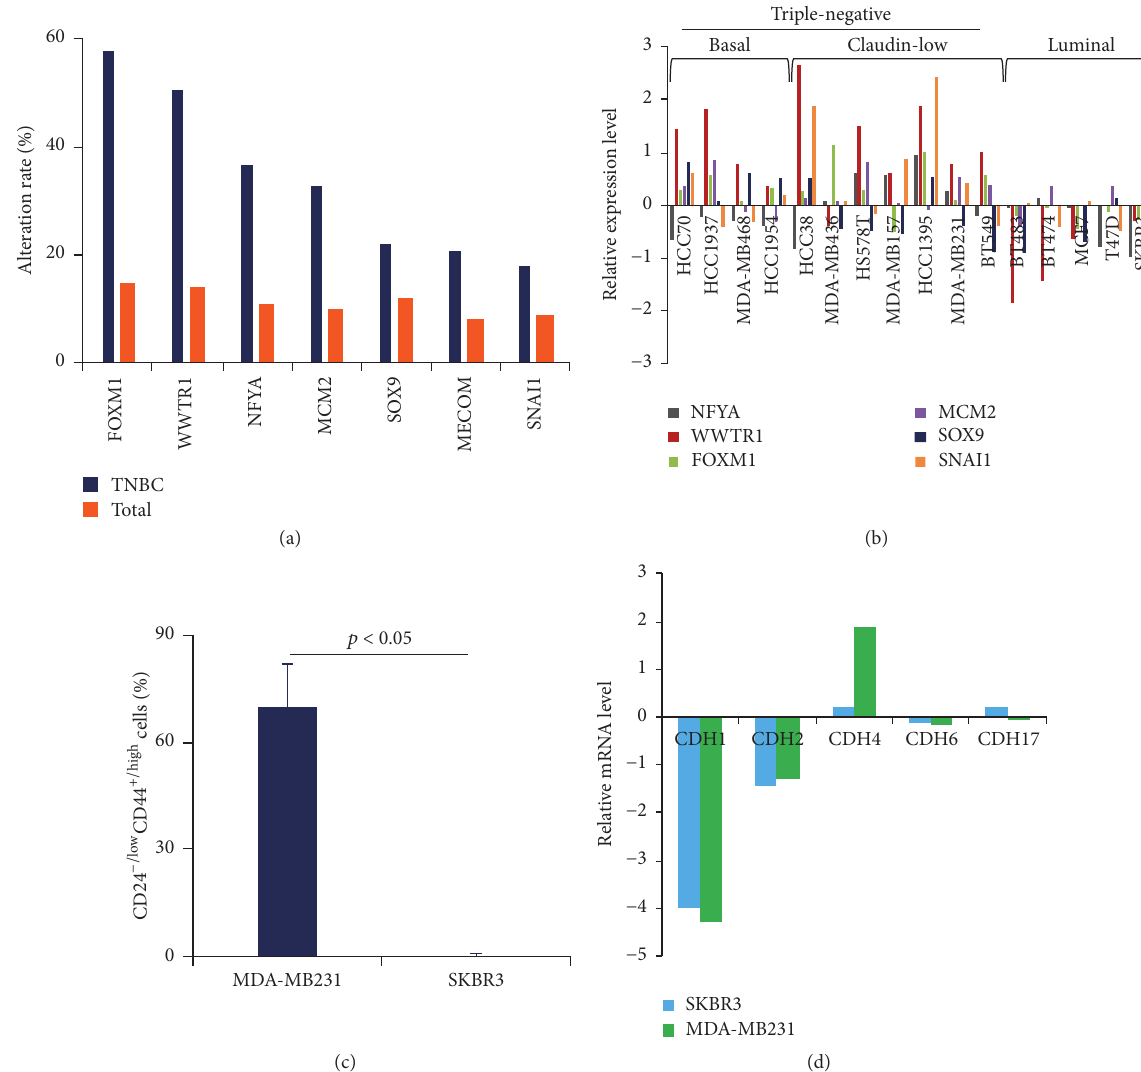
Figure 3: Stem cell-related transcription factors and cancer stem cells are enriched in TNBC cells. (a) The alteration rates of stem cell-related transcription factors (SC-TFs) in TCGA breast cancer samples ( 𝑛 = 960 ) or TCGA TNBC samples ( 𝑛 = 116 ). (b) The expression levels of SC-TFs were elevated in TNBC cells including basal-like and claudin-low. The expression data of the indicated SC-TFs were retrieved from breast cancer cell lines dataset (ArrayExpress accession number E-MTAB-181) by suing UCSC Cancer Genomic Browser according to the instructions. (c) The population of CSCs was higher in basal-like cells MDA-MB231 but lower in luminal subtype of cells SKBR3. The population of CSCs was determined by the staining of stem cell marker CD 24 −/ low CD 44 +/ high followed by flow cytometry. (d) The expression levels of CDH1, 2, 4, 6, and 17 in TNBC claudin-low MDA-MB231 cells and luminal subtype of cells SKBR3. The expression data of CDH1, 2, 4, 6, and 17 in both cell lines were retrieved from the same dataset as described in